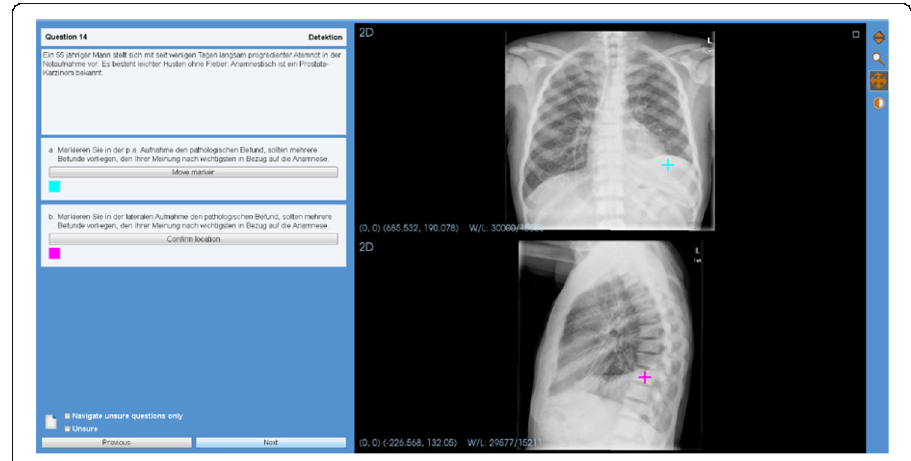
Fig. 2 Individual computer task in VQuest program with perception question in which students could navigate, zoom, and place markers (crosses) in